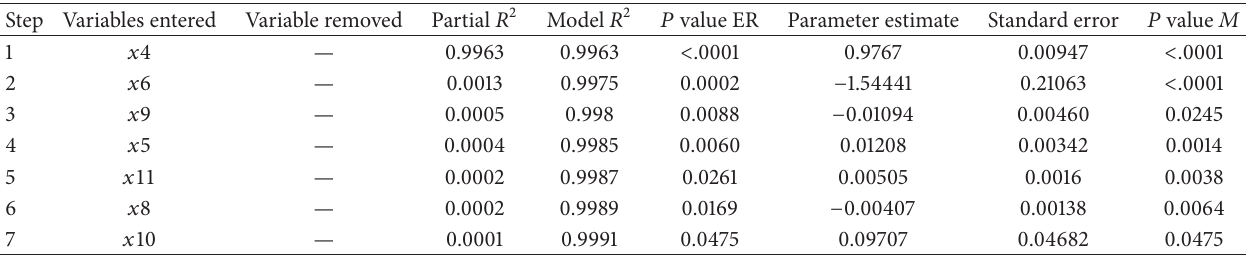
Table 7: Relative contribution (partial and model 𝑅 2 ), 𝐹 value, and probability in predicting wheat grain yield by the stepwise procedure analysis under noninoculation condition and different water